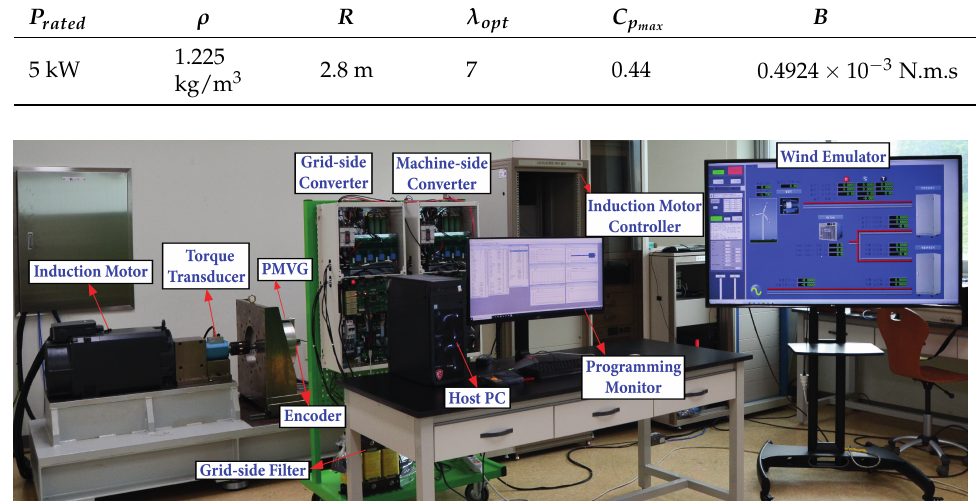
Figure 21. Overall configuration of 5 kW PMVG-based WECS lab experimental setup